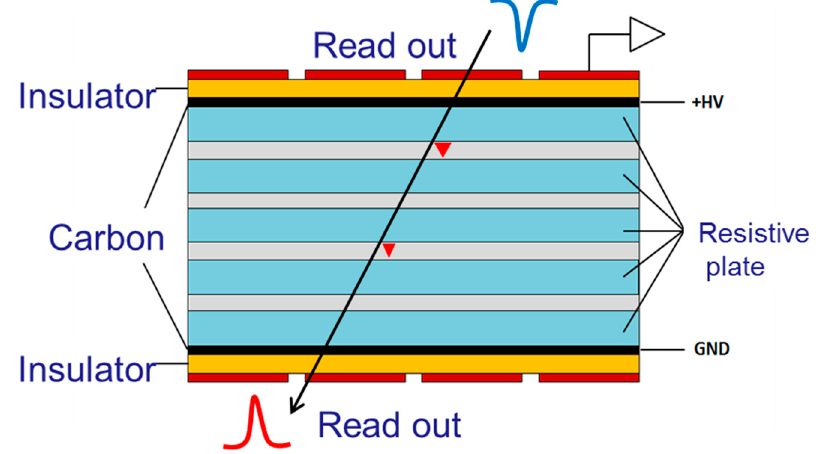
Figure 1. Schematic sketch of a multigap resistive plate chamber (MRPC) detector. The avalanches (red triangles in the gaps) induce negative signals (blue pulse) on the top anode electrodes and positive signals (red pulse) on the bottom cathode electrodes.